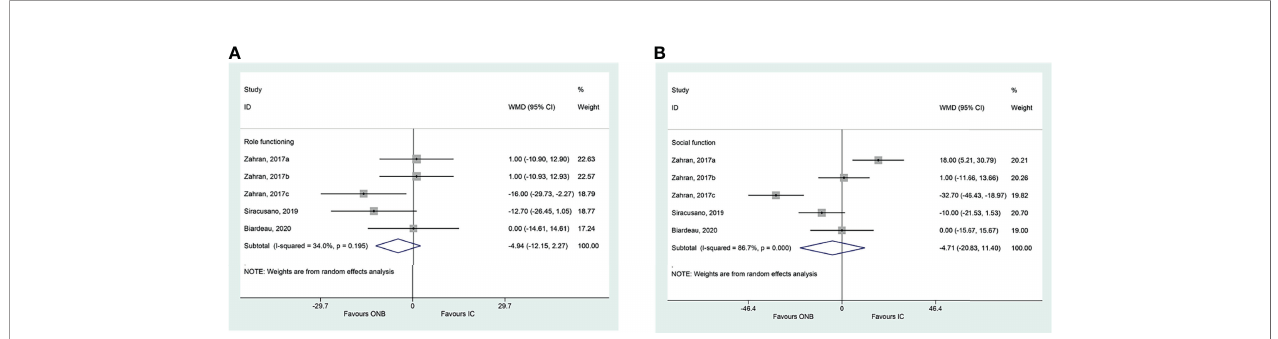
FIGURE 3 | (A) Forest plot of role functioning in women with bladder cancer who underwent ileal conduit diversion (IC) or orthotopic neobladder (ONB). (B) Forest plot of social functioning in women with bladder cancer who underwent ileal conduit diversion (IC) or orthotopic neobladder